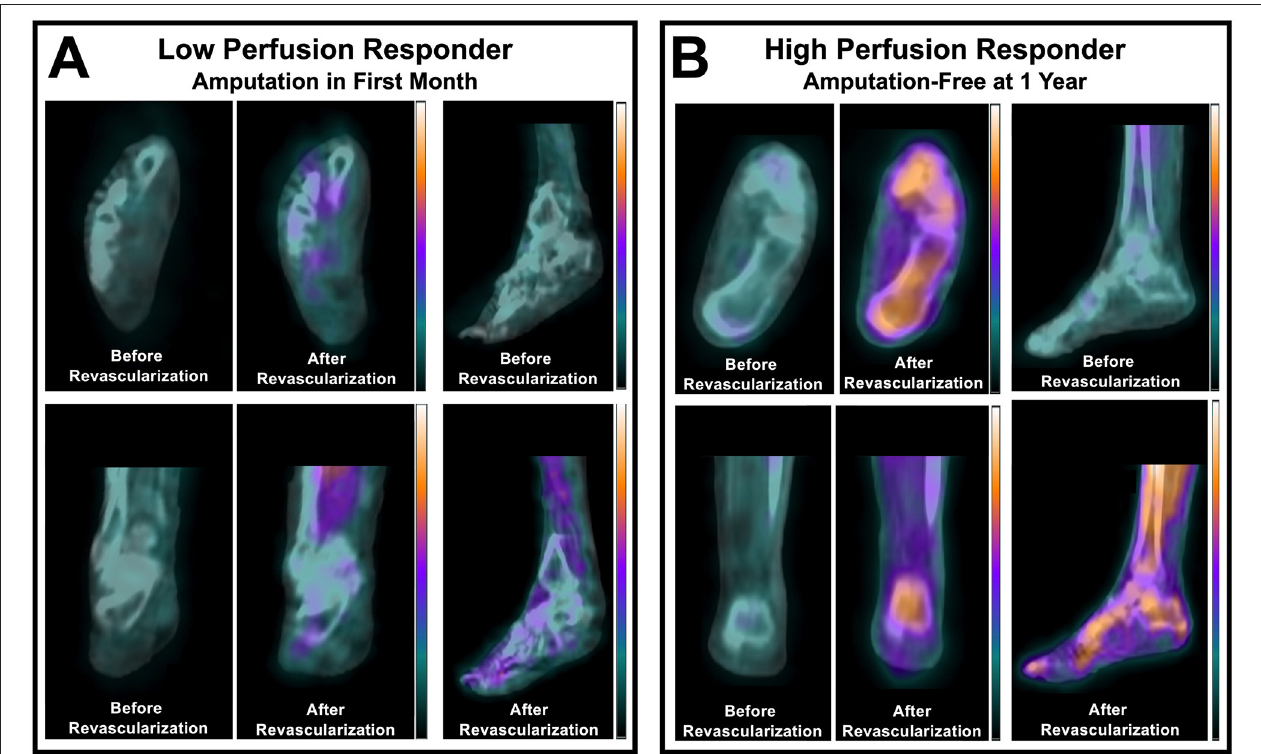
FIGURE 1 | SPECT/CT imaging of the perfusion response to lower extremity revascularization in patients with CLTI. Non-invasive imaging identified differential perfusion responses to peripheral balloon angioplasty in (A) a patient with a low perfusion response who underwent amputation within one month, and (B) a patient who had a high relative perfusion response and remained amputation-free for one year after intervention. Adapted from Chou et al. (22). For a complete description of perfusion imaging methodology, please refer to Chou et al.